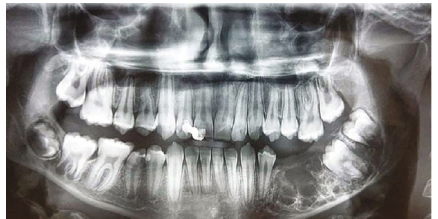
Figure 1: Preoperative panoramic radiograph.